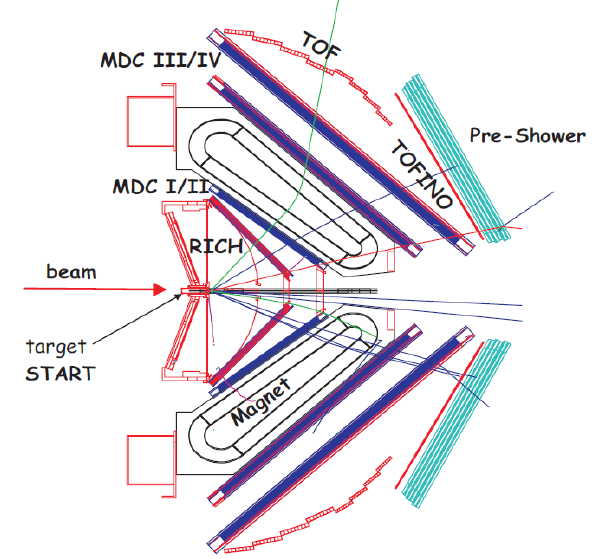
Figure 1. Schematic layout of the HADES detector in the con- figuration used for this experiment.